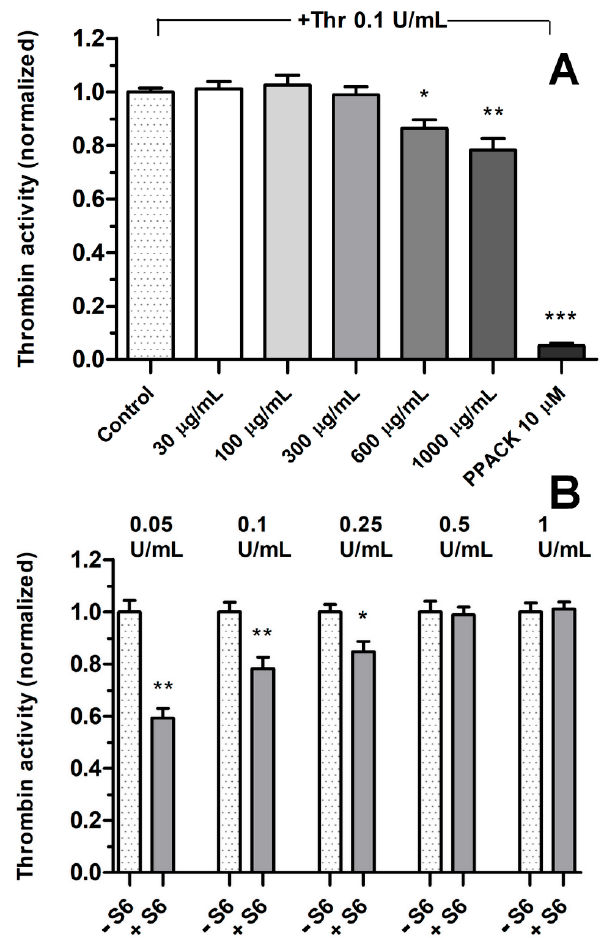
Figure 3. Thrombin activity in the presence of increasing S6 concentrations. Bovine thrombin (0.1 U/mL) was incubated with the indicated increasing concentrations of S6 for 10 min at room temp. This was followed by 2 min incubation at 37 °C in the microplate reader. The reaction was initiated by the addition of chromogenic substrate S-2238 (4 mM) and an increase in absorbance (using 405 nm wavelength) associated with the appearance of the reaction product was measured for 10 min with stirring. The results were normalized to control samples containing vehiculum (saline) instead of S6. The effect of the increasing S6 concentrations on thrombin activity was compared with PPACK (direct thrombin inhibitor) as a positive control ( A ). Samples containing indicated thrombin activities were incubated with saline (control sample, − S6) or with S6 (+S6) at concentration 1 mg/mL ( B ). The results are means ± SD from 5 independent experiments, each in triplicate. * p < 0.05; ** p < 0.01; *** p < 0.001 vs.